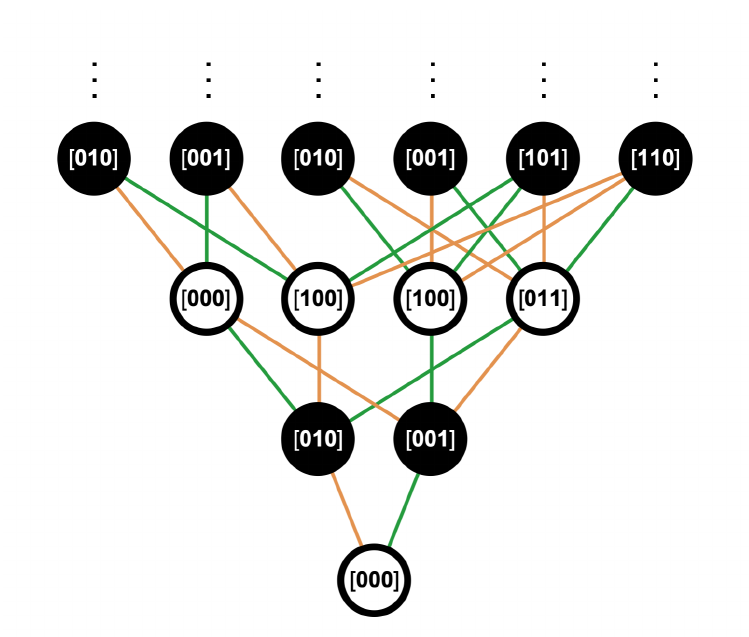
Figure 11 . Adynkra Diagram for 6D minimal scalar superfield.